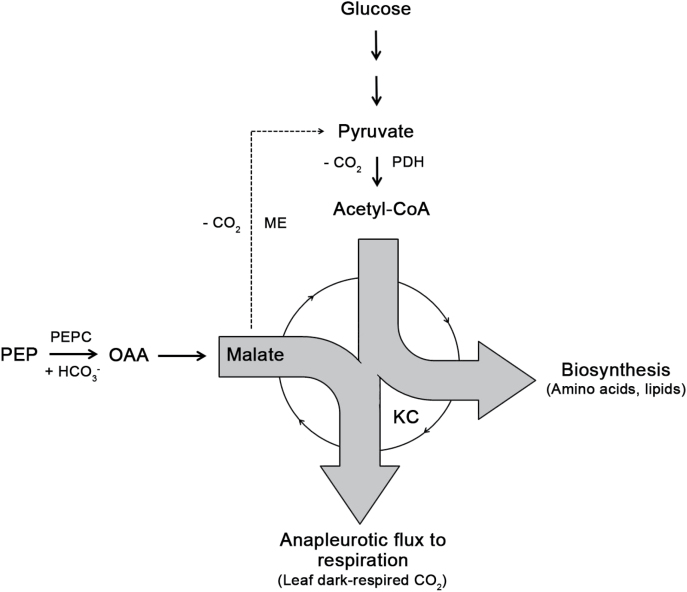
Simplified schematic of respiratory processes in potato leaves. Breakdown of glucose during glycolysis produces pyruvate, which is converted into CO2 and acetyl-CoA by the pyruvate dehydrogenase reaction (PDH). Acetyl-CoA is used for biosynthesis rather than for respiration, causing a drain of Krebs cycle (KC) intermediates. An anapleurotic flux via phosphoenolpyruvate carboxylase (PEPC) replenishes KC intermediates to maintain the functionality of the KC. Malate enters the KC and is used as carbon source for leaf dark-respired CO2. Dashed line indicates an alternative CO2 producing reaction via malic enzyme (ME). PEP, phosphoenolpyruvate; OAA, oxaloacetate.